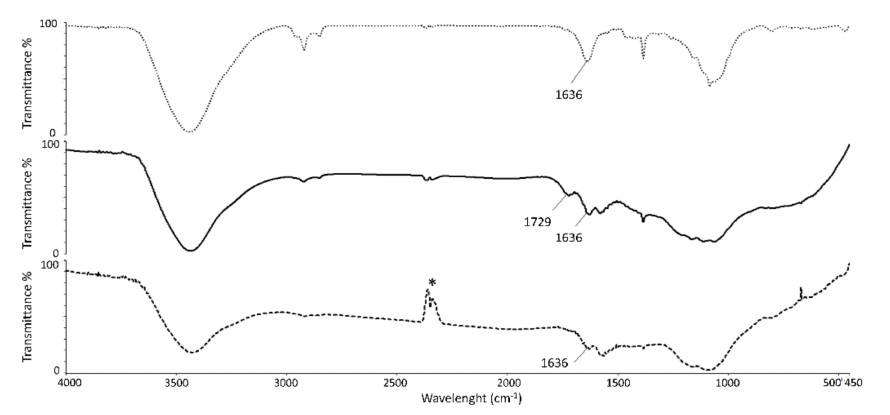
Figure 3. IR spectra of pristine MWCNTs (top curve), COOH − MWCNTs (middle curve), and NH 2 − C 2 − MWCNTs (bottom curve). * band of atmospheric CO 2 not completely eliminated by background